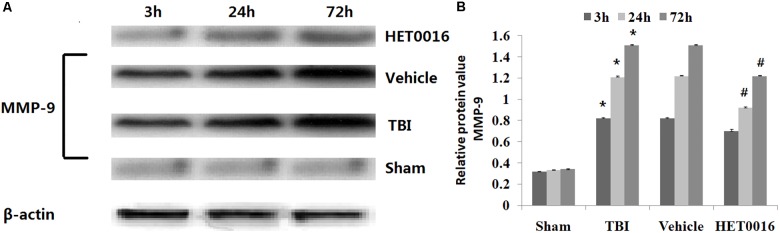
The effect of HET0016 on the expression of matrix metalloproteinase-9 (MMP-9) at 3, 24, and 72 h after injury. (A) Representative photos of MMP-9. (B) The quantitative analysis of the ratio of JNK. ∗P < 0.05 compared with the corresponding sham group at the same time point; #P < 0.05 compared with the vehicle-treated group.